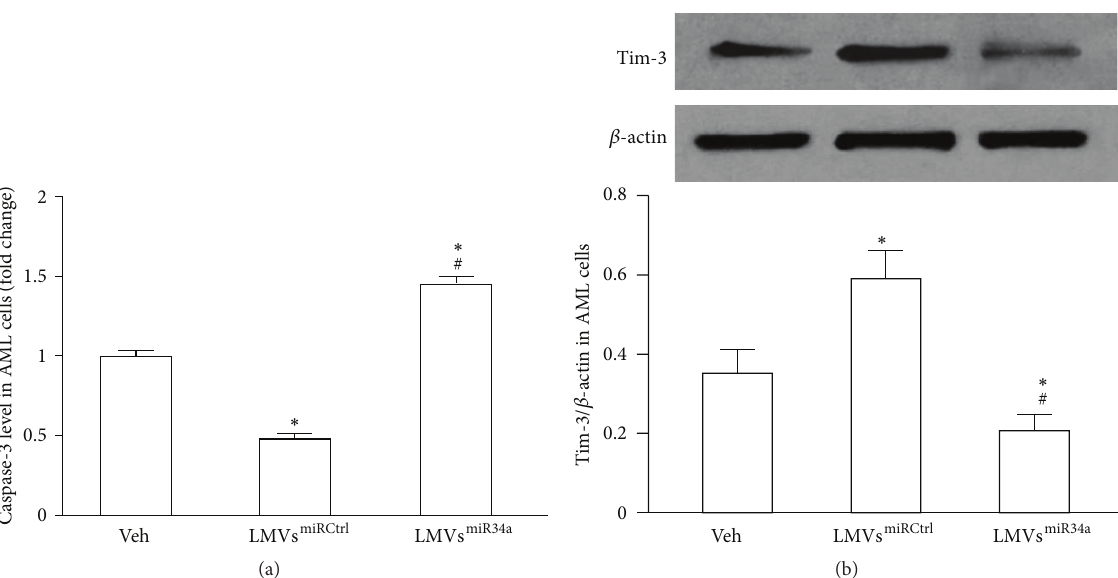
Figure 5: Effects of LMVs miRCtrl and LMVs miR 34 a on the levels of caspase-3 and Tim-3 protein in AML cells. (a) The activity of caspase-3 in AML cells which was determined by ELISA. (b) The expression of Tim-3 protein in AML cells which was determined by western blot. Data represents mean ± SEM. ∗ 𝑃 < 0.05 versus veh; # 𝑃 < 0.05 versus LMVs miRCtrl . Veh: fresh culture medium; LMVs miRCtrl : LMVs generated from miRCtrl transfected LSCs; and LMVs miR 34 a : LMVs generated from miR34a mimic transfected LSCs.